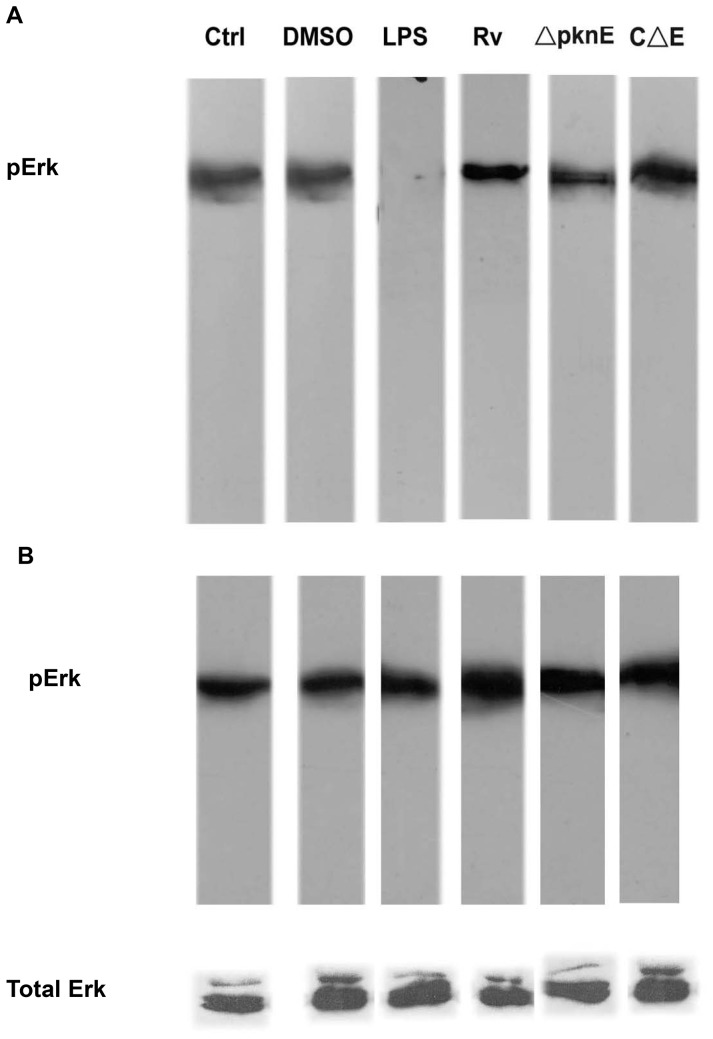
ΔpknE infected macrophages potentiates a crosstalk between SAPK/JNK and Erk½, and p38 and Erk½ pathways.Cells to be infected were treated with A) SAPK/JNK and B) p38 inhibitors, for 1 h and lyzed 1 h post infection. The lysates were subjected to western blotting and probed with phospho and non phospho Erk½ antibodies. The results from three independent experiments are shown. The abbreviations Ctrl denote control and LPS denotes lipopolysaccharide.